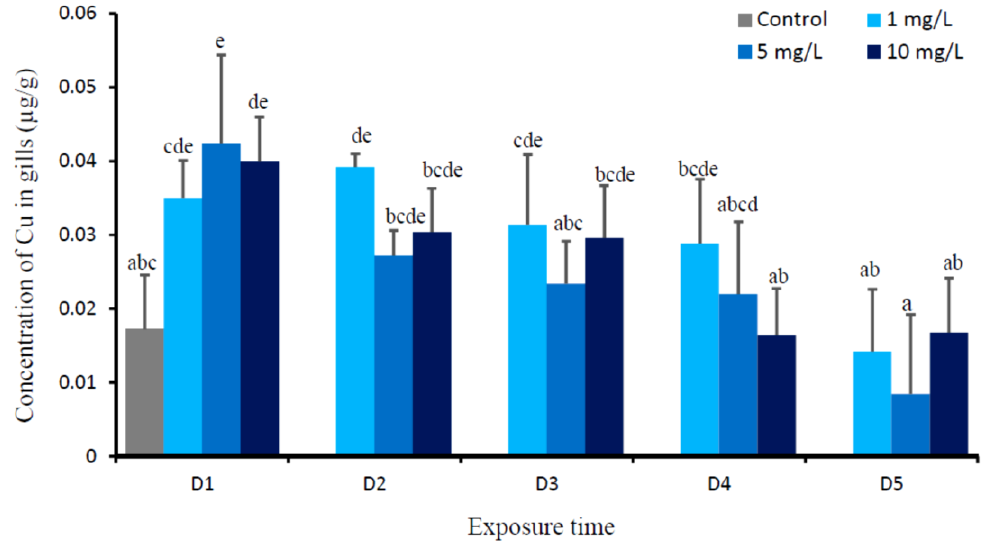
Figure 1. Mean concentration of Cu (µg/g) in gills of O. niloticus of the control group and after exposed to 1, 5, and 10 mg Cu/L. Different lowercase letter indicates significance difference according to Tukey multiple comparison test ( P < 0.05).